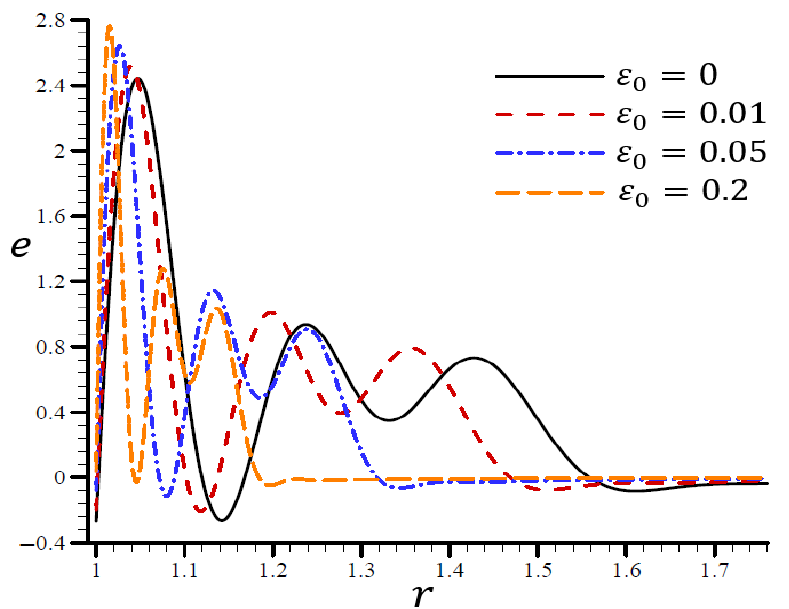
Figure 18. The influence of ε 0 on volumetric strain e through the radial direction of the spherical hole using the RTPL model.